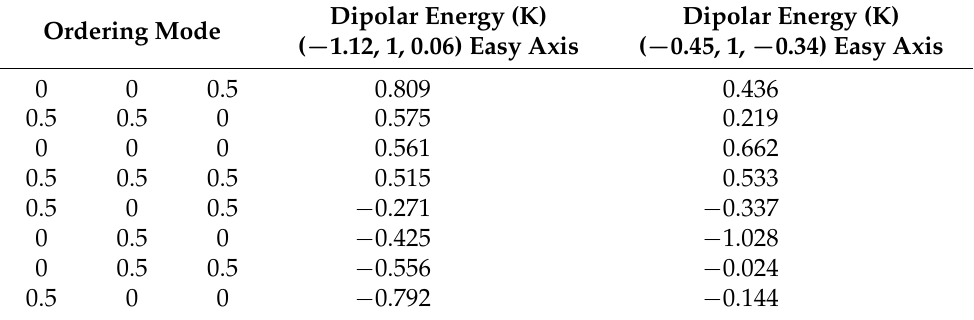
Table 2. Dipolar stabilisation energies for the S = 35/2 ground state of Fe 19 calculated for different modes of magnetic ordering using, firstly, the previously proposed Fe1-Fe2 easy spin axis, for which (0 0 0.5) is the most stable mode, and secondly the axis determined from this study. A spherical sample is assumed for the case of the (0 0 0) ferromagnetic ordering mode. Negative values are unstable.